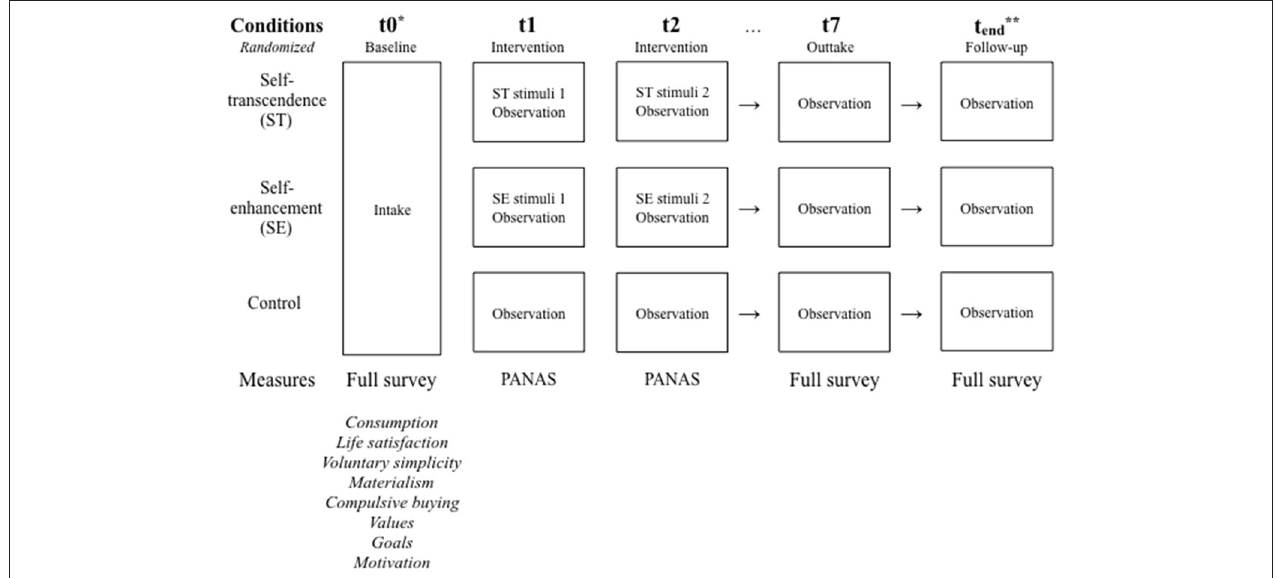
FIGURE 1 | Study outline. *t + 1 equals one day; t0 − t7 are completed within one week. **t end will take place one month after intervention completion